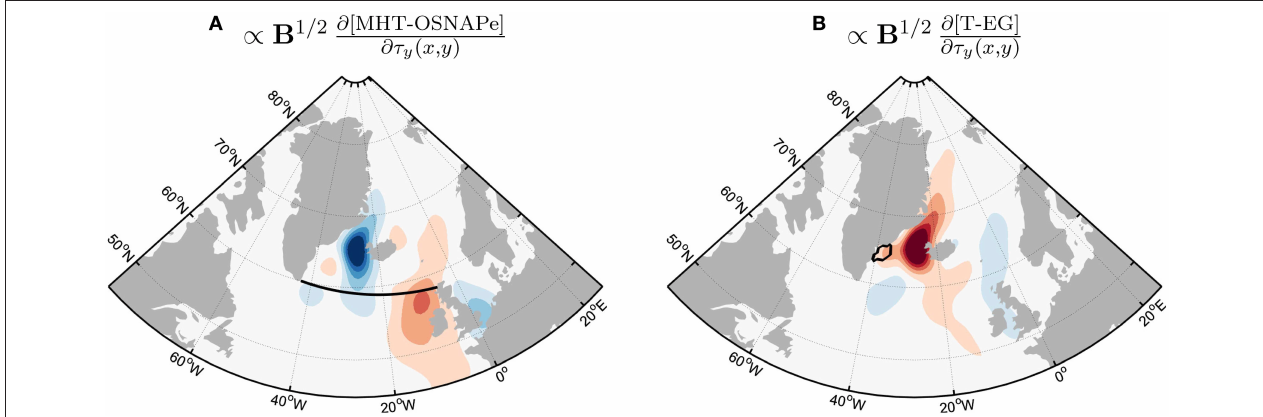
FIGURE 8 | Linear sensitivity of (A) meridional heat transport across the OSNAP-East section (MHT-OSNAPe) and (B) subsurface ocean temperature (150–550m) close to the Southeast Greenlandic coast (T-EG) to meridional wind stress τ y , derived with the ECCO adjoint model, weighted by the square root of the prior error covariance matrix B , and normalized. The solid black contour delineates the (A) OSNAP-East transect and (B) horizontal area for the respective calculations of (A) heat transport and (B) mean temperature. Sensitivities are accumulated over 5 years. Red (blue) colors indicate that an increase in the northward wind stress would lead to a subsequent increase (decrease) in (A) MHT-OSNAPe and (B) T-EG on a 5 year timescale. (A) An observed state direction (truncated to the control τ y ), informed by MHT-OSNAPe measurements. (B) The target direction (truncated to the control τ y ) for the unobserved quantity T-EG. The good projection of (A,B) reflects a high potential for the observed quantity MHT-OSNAPe to inform the unobserved quantity